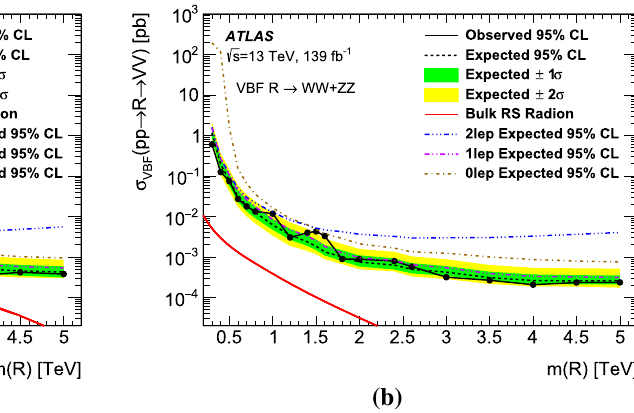
Fig. 12 Observed (black solid curve) and expected (black dashed and yellow (outer) bands represent ± 1 σ and ± 2 σ uncertainty in the expectedlimits.Limitsexpectedfromindividualleptonicchannels(dot- curve) 95% CL upper limits on the a ggF and b VBF production cross- √ s = 13 TeV in its diboson ( WW and dashed curves in blue, magenta, and brown) are also shown for com- section of an RS radion at Z Z ) decay mode as functions of the RS radion mass, combining the parison. Limits are calculated in the asymptotic approximation below R → WW and R → Z Z searches in the three leptonic channels. The 3 (1) TeV and are obtained from pseudo-experiments above that for ggF (VBF)production.Theoreticalpredictions(redsolidcurve)asfunctions theoretical prediction for B ( R → WW )/ B ( R → Z Z ) is assumed for of the RS radion mass are the combination of the WW and Z Z decay modes. The green (inner)